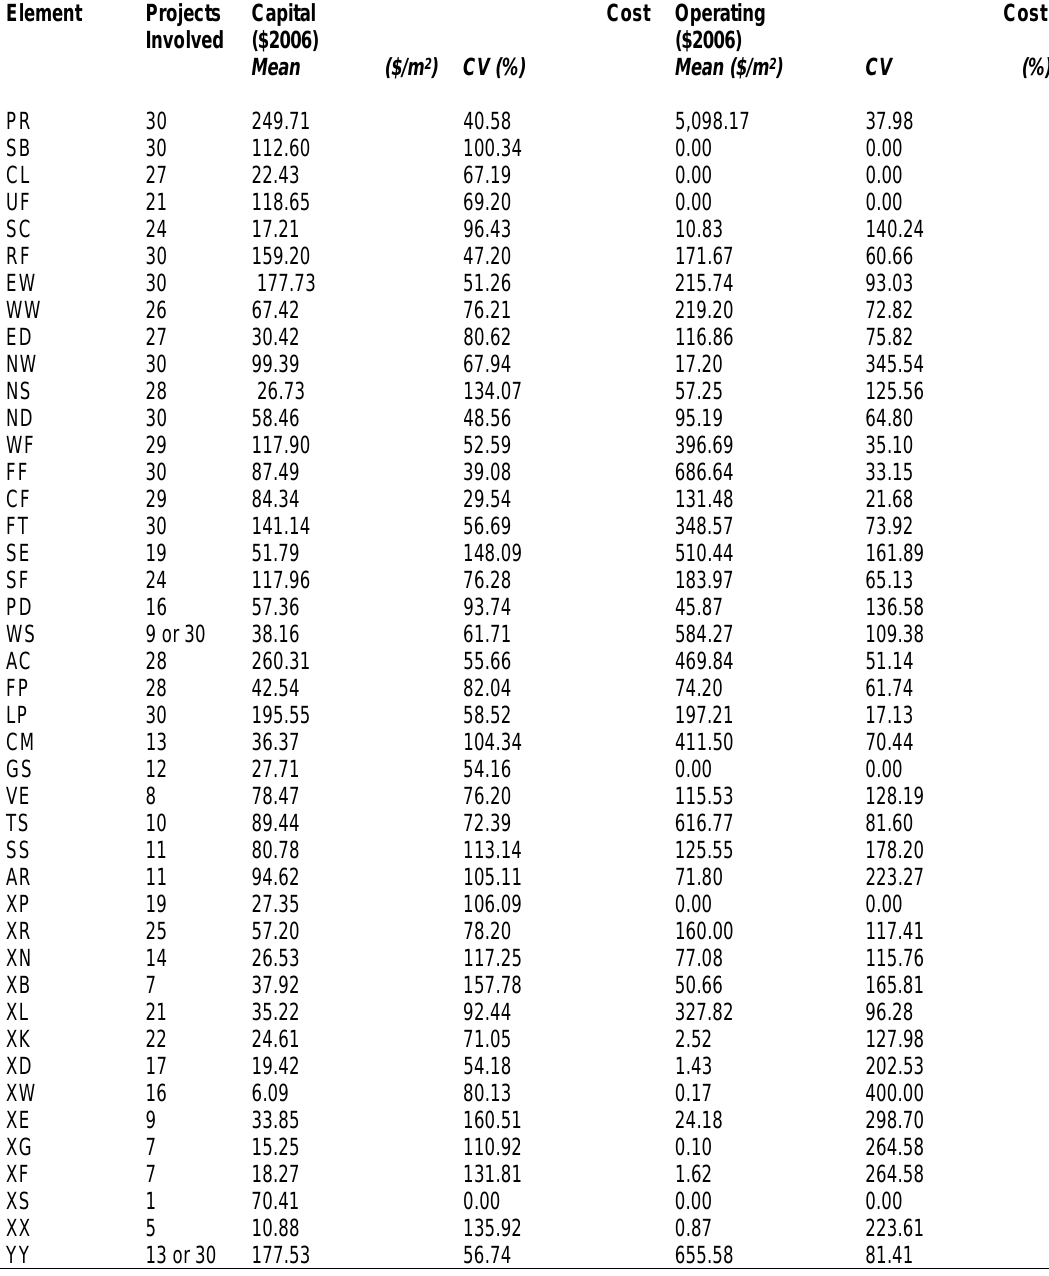
Table 4: Statistical Summary for Cost by Element ( Langston